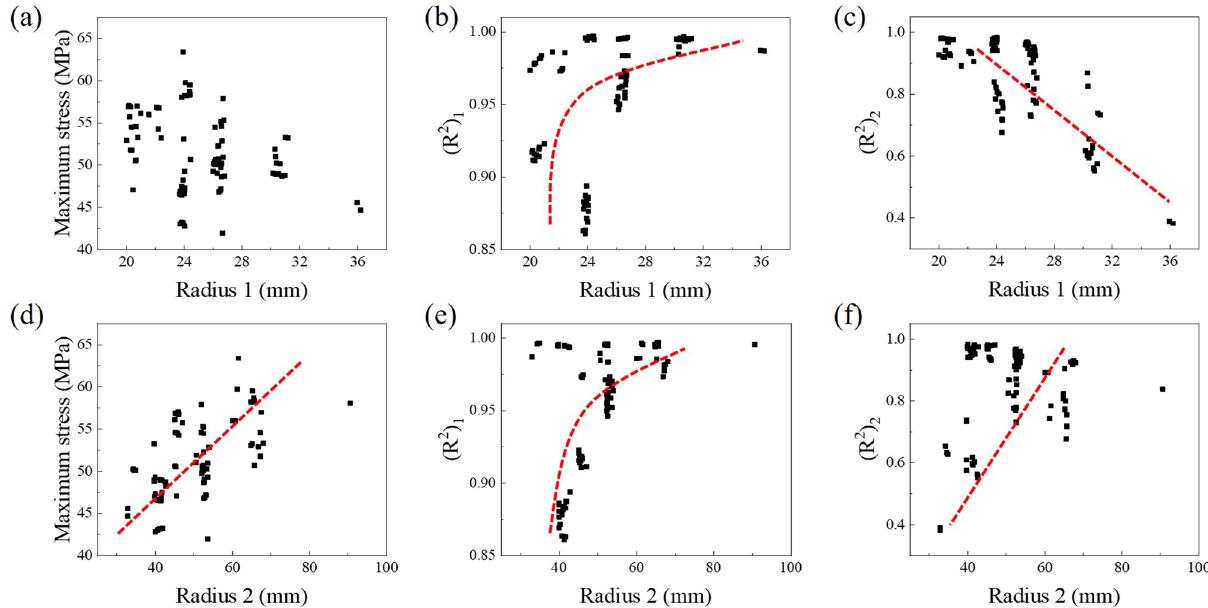
2 ) 2 ) 1 and ( R 2 ) results according to design variables of